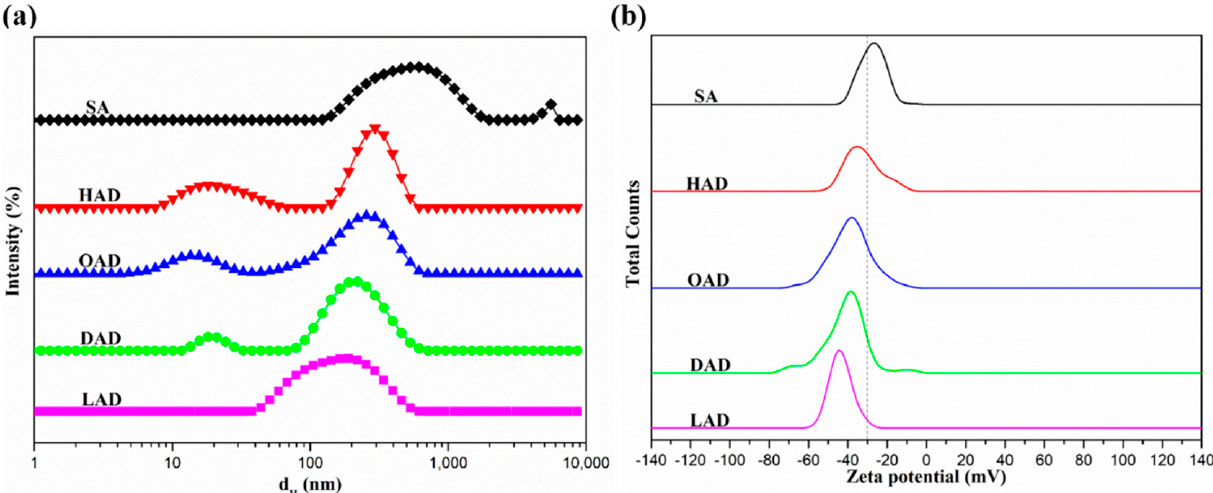
Figure 7. ( a ) Hydrodynamic diameter distribution and ( b ) Zeta potential distribution of SA, HAD, OAD, DAD, and LAD self-aggregated micelles. Table 2. Comparison of performance parameters of AAD with different hydrophobic side groups.